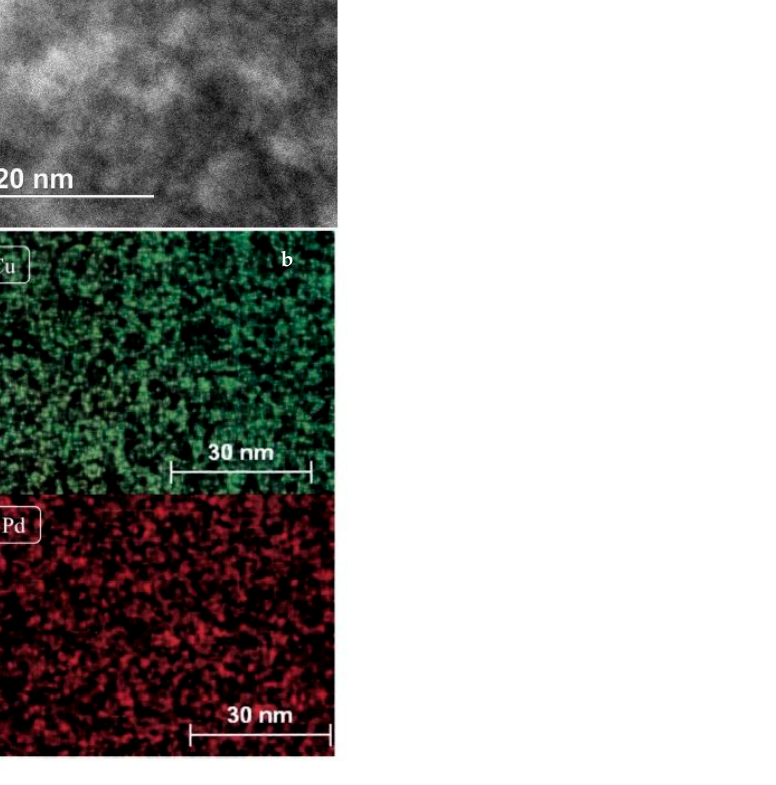
Figure 6. EDXS elemental mapping of the Cu-Pd50 specimen: ( a ) Cu and ( b ) Pd. The Cu cluster is indicated by an arrow.